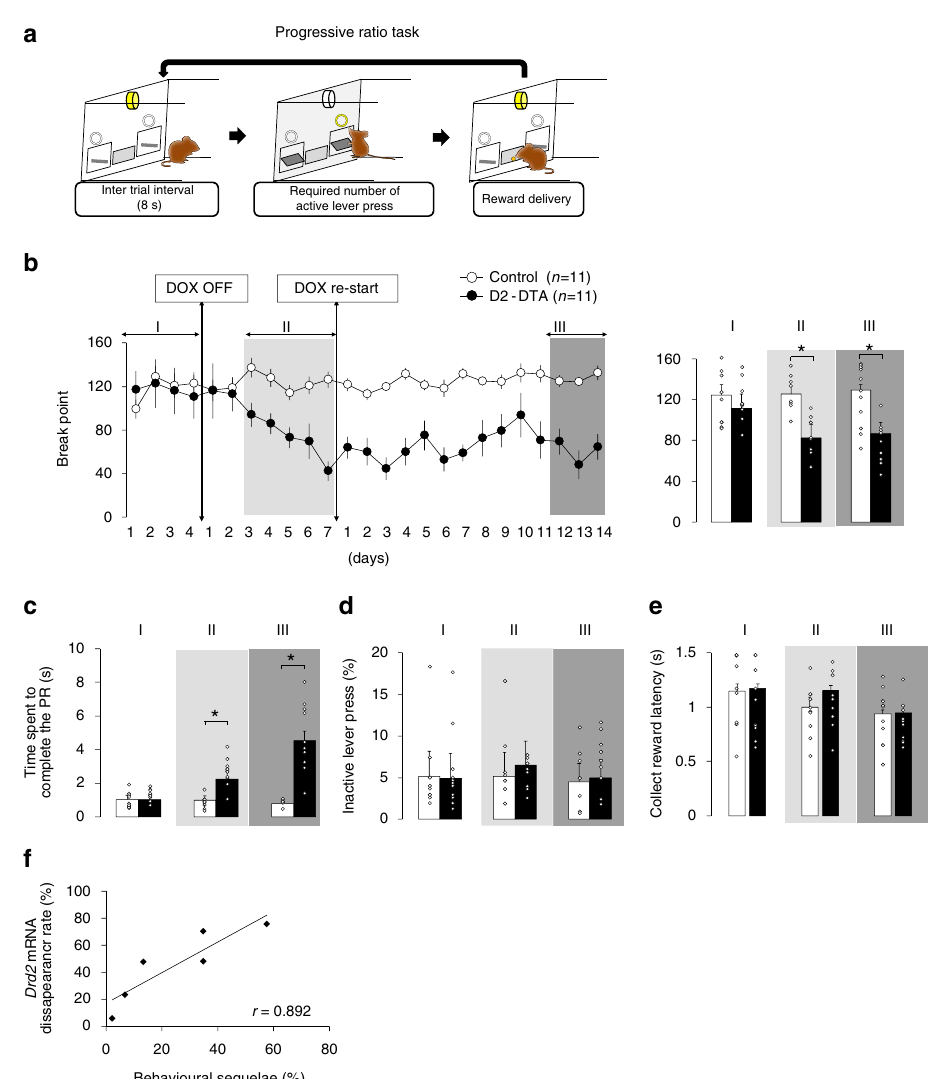
Figure 5 | Ablation of VLS D2-MSNs produces chronic decreased motivation. ( a ) Schematic illustration of the PR task sequence. ( b – e ) Temporal changes in behavioural parameters in the PR task. DOX-off for 7 days followed by a restart regimen was used to confine DTA induction within the VLS. The bar graphs show the behavioural parameters averaged over (cid:3) 3 to 0 days before (phase I), 3–7 days after (phase II) DOX termination and 12–14 days after DOX restart (phase III) in the PR task. The black circles represent data from the bigenic group ( n ¼ 11) and white circles represent data from monogenic controls ( n ¼ 11). DOX termination decreased break points ( b , phase II and III) and prolonged time spent to complete the PR ( c , phase II and III). The DOX-off treatment did not change the number of inactive lever presses ( d ) or collect reward latency ( e ), indicating that associative learning and appetite were spared throughout the experiment. Bars represent the mean and lines represent the s.e.m. * P o 0.05, with post hoc Student’s t -test compared with monogenic control. ( f ) The Drd2 mRNA disappearance rate was correlated with change in break point (behavioural disruption). The behavioural disruption was calculated as: ((break point during DOX restart (days 12 to 14)) in control mice minus break point during DOX restart ((days 12 to 14) in bigenic mice)/ (break point during DOX restart (days 12 to 14) in control mice) (cid:2) 100).* P o 0.05, Pearson’s product-moment correlation